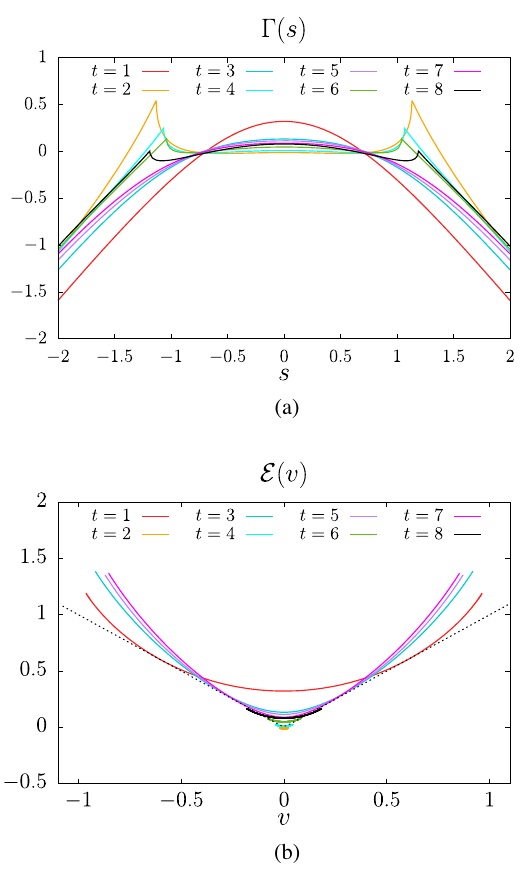
FIG. 11. Weakly entangling gate with x ¼ 0 . 5 [Eq. (72)]: (a) Successive approximations to Γ ð s Þ (see Sec. IVA). For some small t values, Γ ð s Þ is negative around s ¼ 0 . (b) Approximations to E ð v Þ obtained by Legendre transform of (a). Note the small E ð 0 Þ ¼ Γ ð 0 Þ